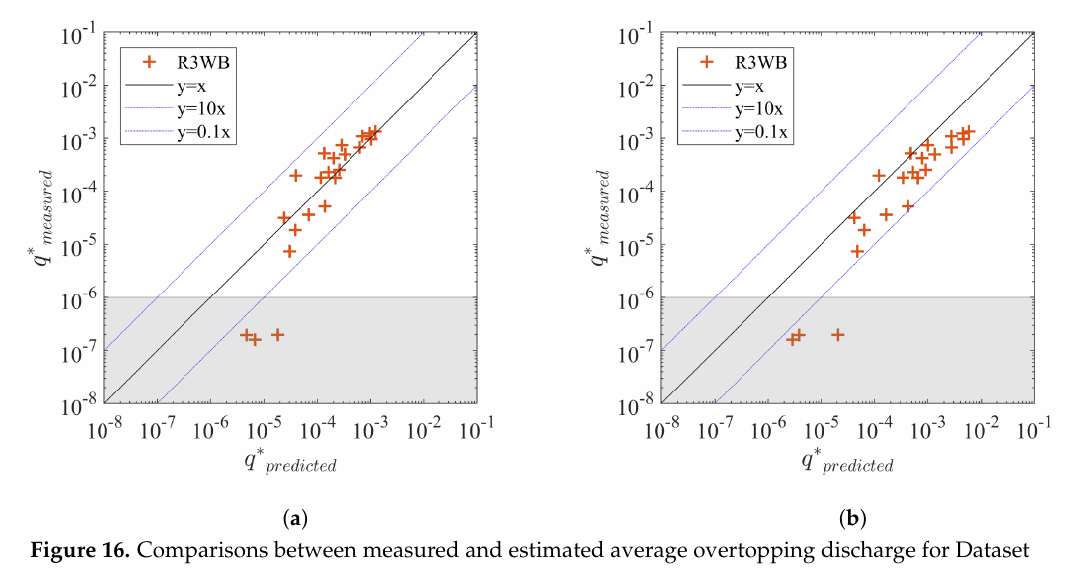
Figure 16. Comparisons between measured and estimated average overtopping discharge for Dataset R3WB by using ( a ) New berm Equation (7) with roughness factor of 0.55 and ( b ) New roughness Equation (8) with TAW berm Equation (A7).